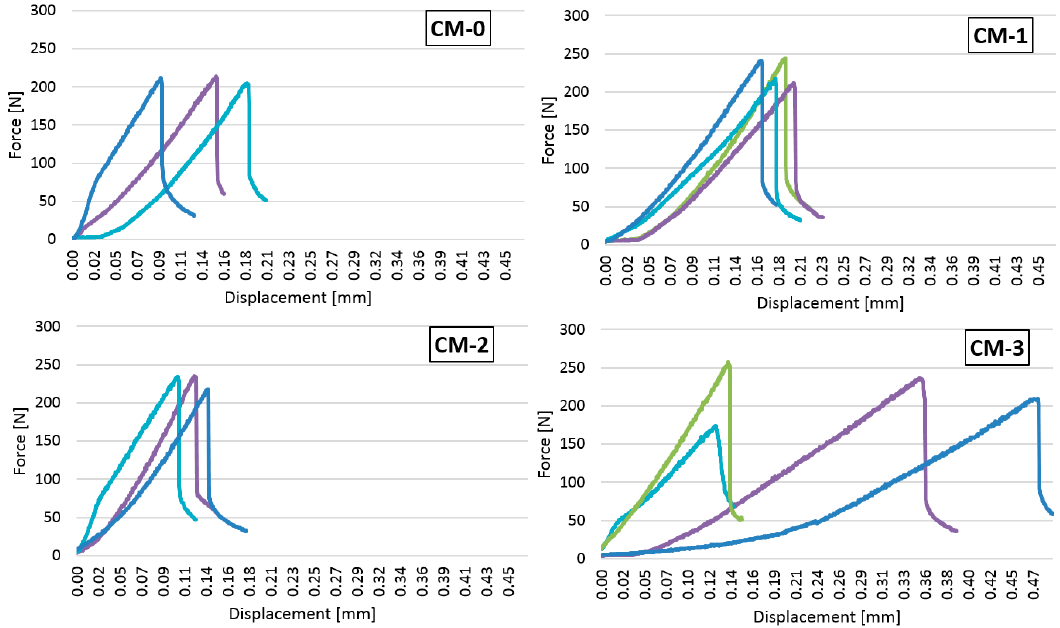
Figure 10. The dependence of the bending force on the displacement of the press head.